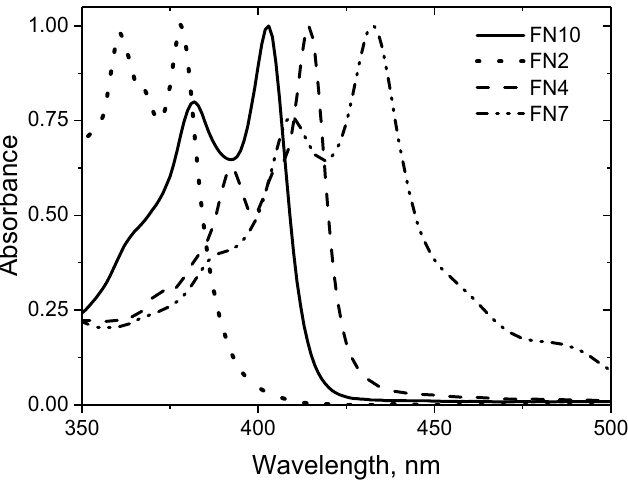
Figure 1. Fragments of the electronic absorption spectra of the selected dyes in ethyl acetate.